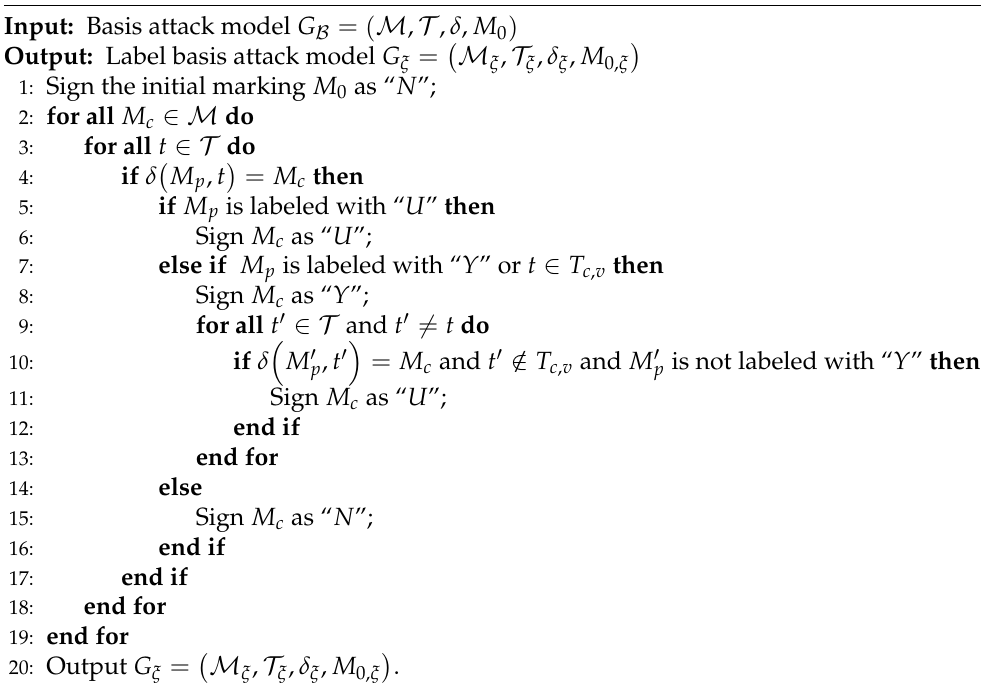
Figure 9. Label automaton A ξ . Algorithm 3 Building a label basis attack